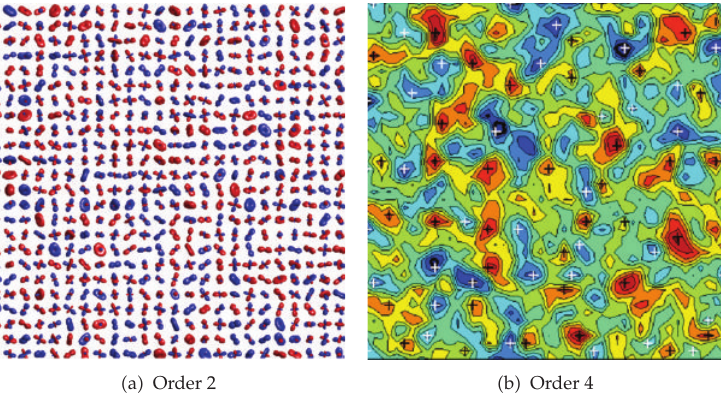
Figure 6: A sample random second-order field and the error di ff erence.